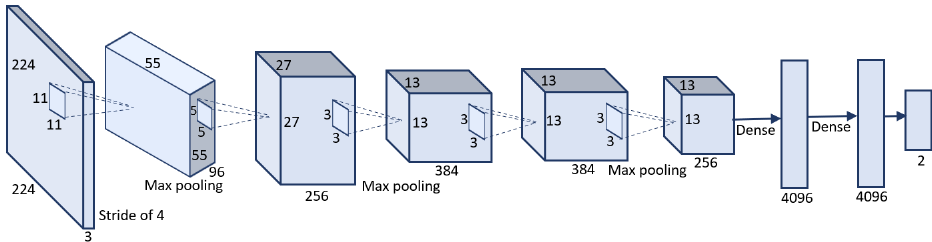
Figure 9. A pre-trained AlexNet CNN detail structural framework layers